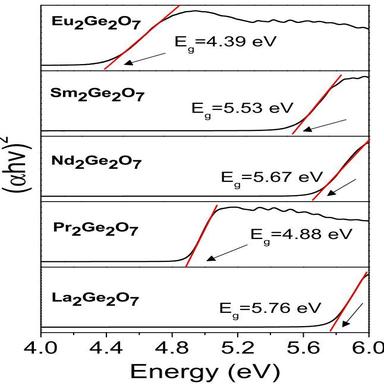
Energy gap (Eg) for the triclinic pyrogermanates La2Ge2O7, Pr2Ge2O7, Nd2Ge2O7, Sm2Ge2O7, and Eu2Ge2O7.